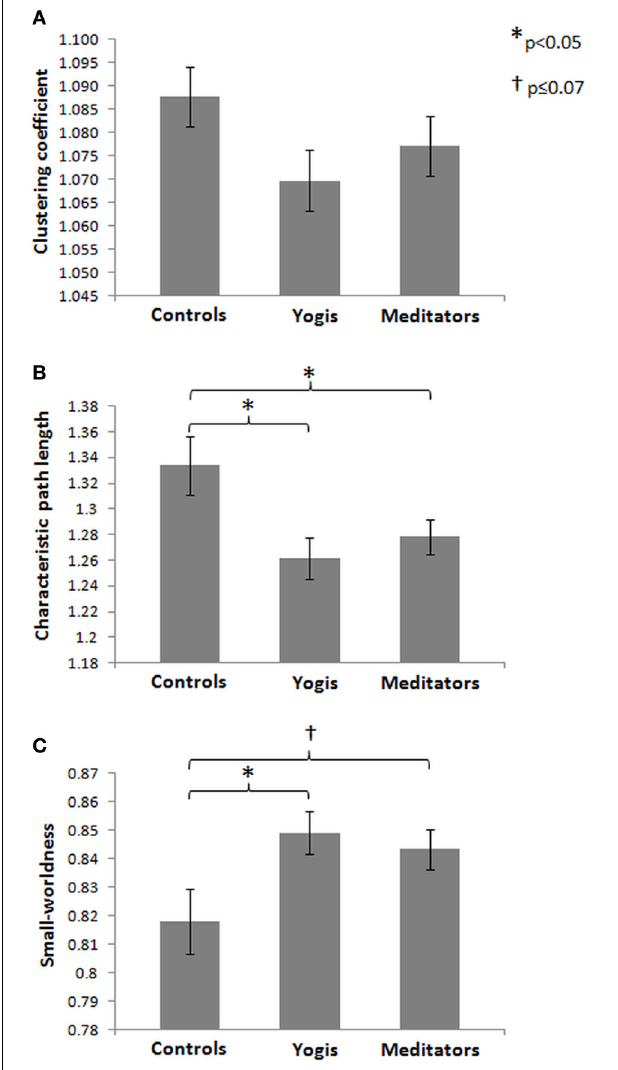
FIGURE 3 | Mean of normalized clustering coefficient (A), normalized characteristic path length (B), and small-worldness (C) for controls, yoga practitioners, and meditators, based on weighted resting state brain functional networks. Error bars represent the standard error of the mean. P -values are based on two-tailed independent samples t -tests.